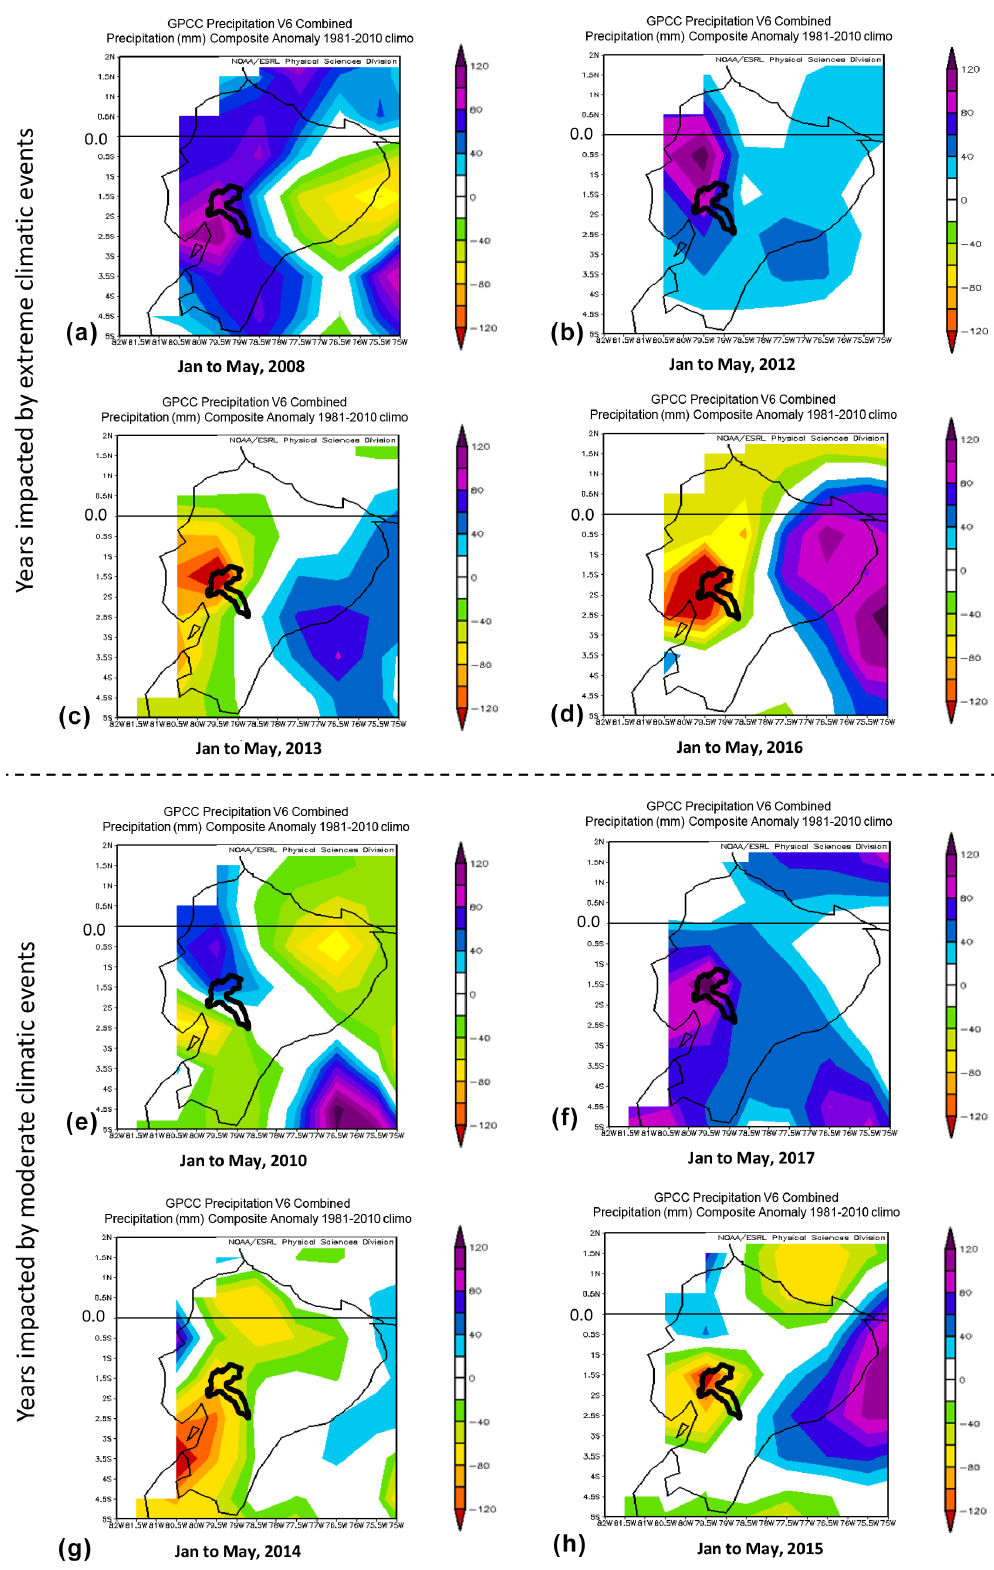
Figure 3. Positive anomalies of precipitation (flood) in the year (a) 2008, (b) 2012, (e) 2010 and (f) 2017. Negative anomalies of precipitation (drought) in the year (c) 2013, (d) 2016, (g) 2014 and (h) 2015. Source: NOAA